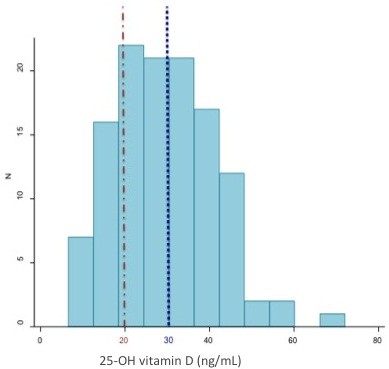
Distribution of serum 25-OH vitamin D levels. Histogram of 25-OH vitamin D levels. The median 25-OH D level in this cohort was 28 ng/mL (IQR 21–37). The majority (54%) of children had levels below current guidelines of sufficiency (30 ng/mL) (dotted line), with almost a quarter (23%) in the deficient (≤ 20 ng/mL) range (dashed line).